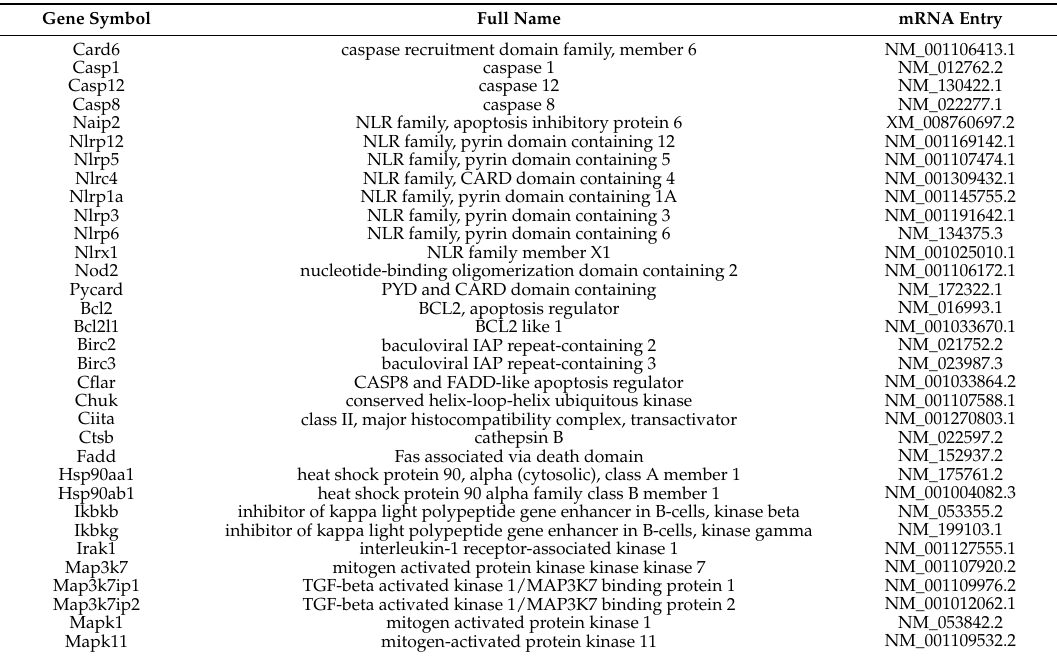
Table A1. Genes analyzed in PCR